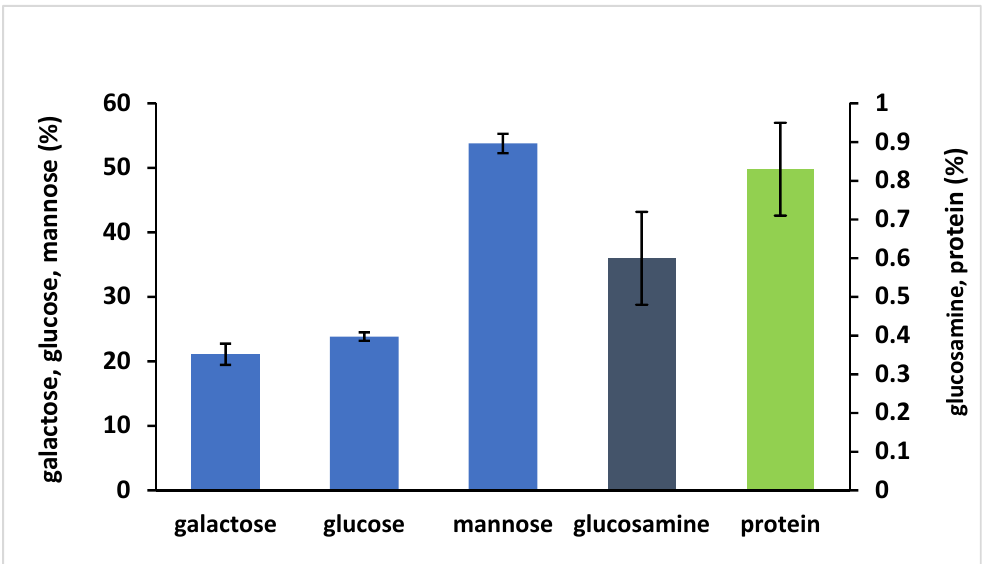
Figure 1. Monosaccharidic composition (expressed as mol %) and proteins content of the freeze-dried polysaccharides (UFS). Error bars represent standard deviation of three analytical replicates, each referred to as experimental duplicates.